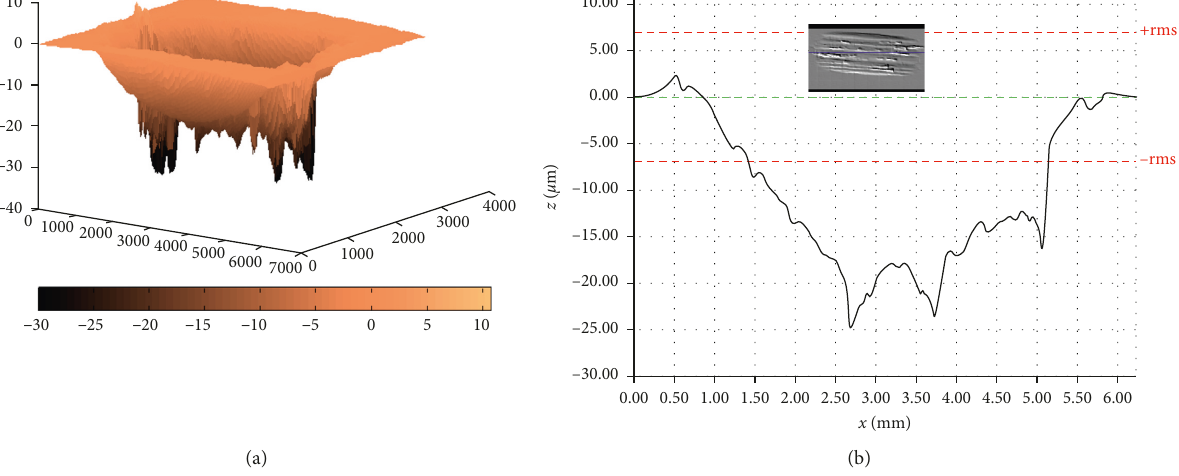
Figure 13: Three-dimensional image of the disk track of steel 1 tested at 40 ° C (a). The maximum profile depth (25 µ m)